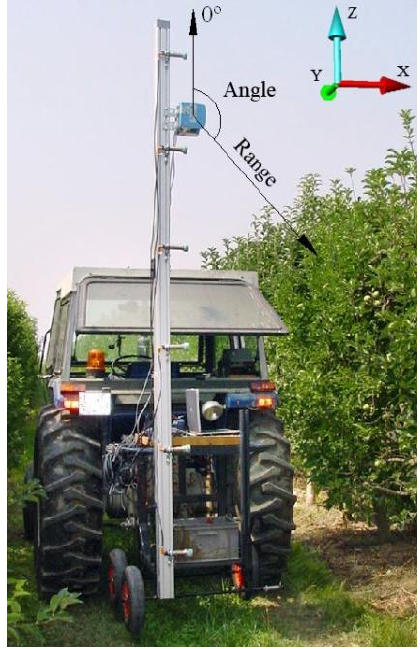
Figure 3. The impact points of the laser beam are determined in polar coordinates. The direction of the laser beam with an angle of 0° is vertical and upward pointing. The Cartesian coordinate system (X,Y,Z) used in the field and laboratory is also